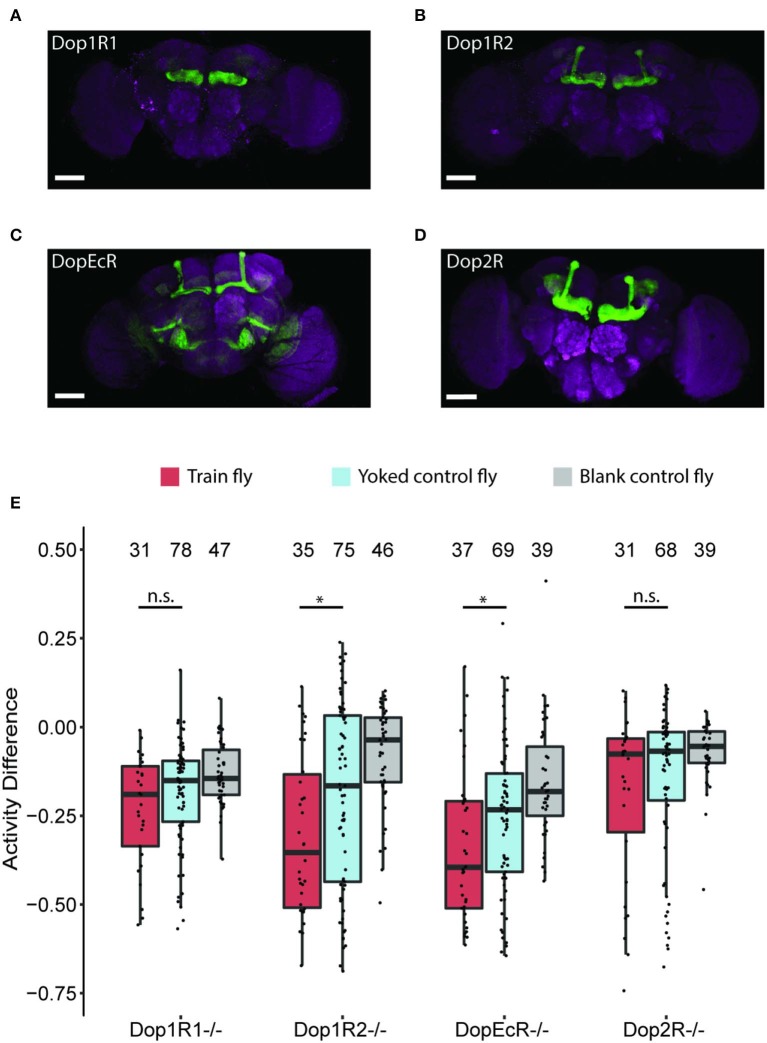
Anti-instinctive learning performance in dopamine receptor null mutants. (A–D) The expression patterns of the dopamine receptors (anterior view, scale bar: 100 μm). (A) Dop1R1. (B) Dop1R2. (C) DopEcR. (D) Dop2R. (E) Anti-instinctive learning performance in dopamine receptor null mutants. Dop1R1 and Dop2R are involved in flies' anti-instinctive learning revealed by the activity difference (AD) between Pre-Test and Test 2. Sample sizes are indicated at the top of the graph. *p < 0.05.